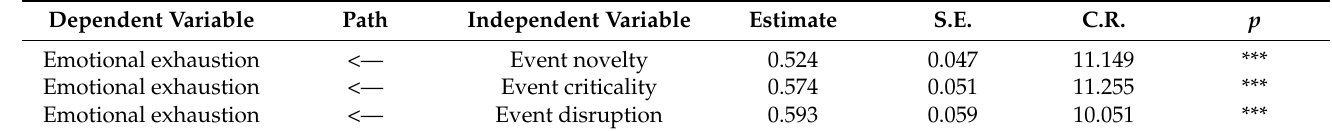
Table 4. Path test of event strength to emotional exhaustion.